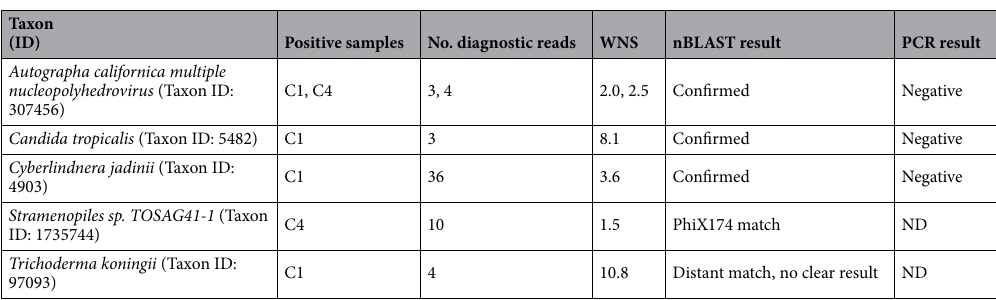
Taxon (ID) Positive samples No. diagnostic reads WNS nBLAST result PCR